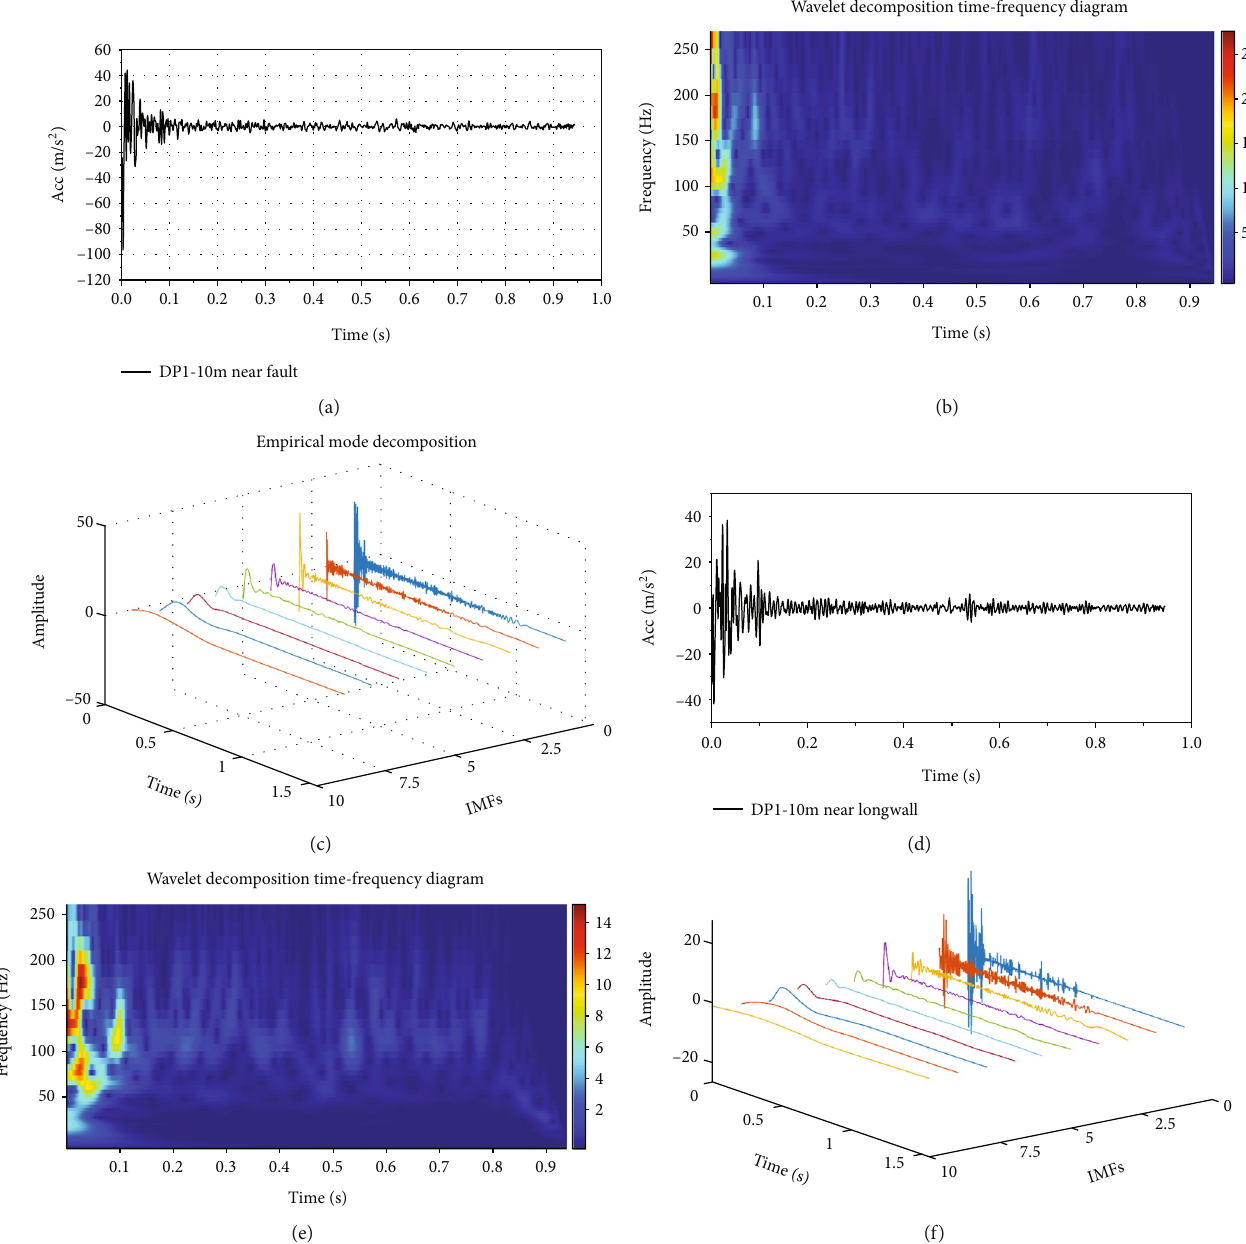
Figure 13: Vertical acceleration, wavelet decomposition time – frequency, and EMD maps of the monitored working face and the vicinity of the fault when the longwall working face is 10m away from the fault under